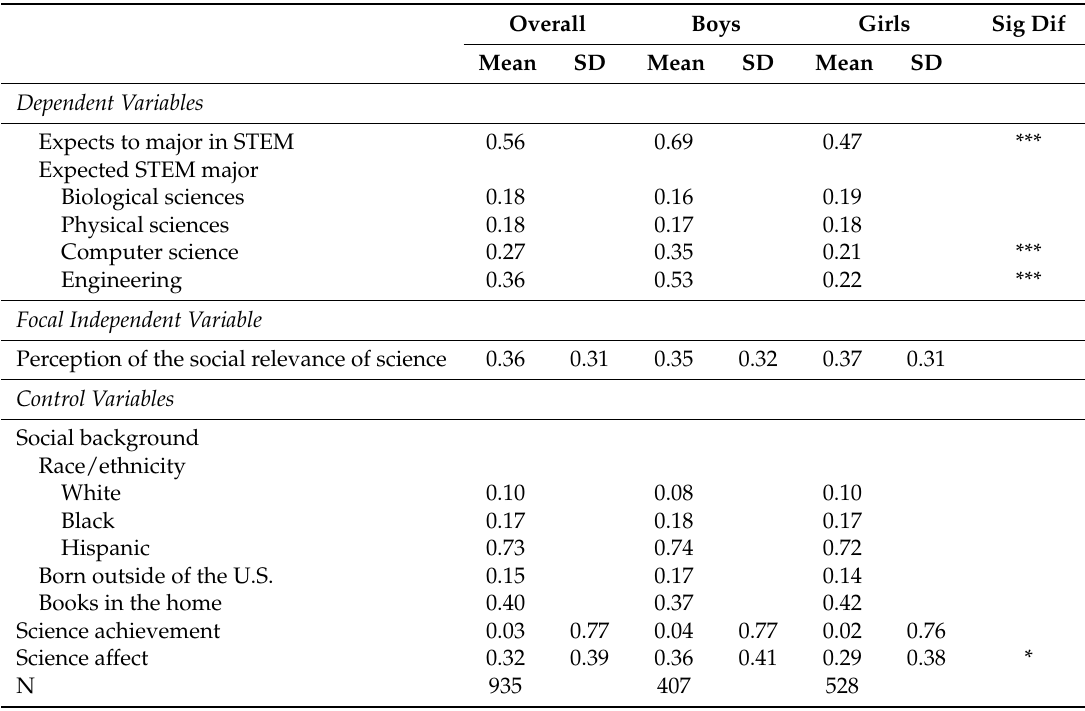
Table 1. Descriptive statistics for pooled sample and reported separately by gender. Overall Boys Girls Sig